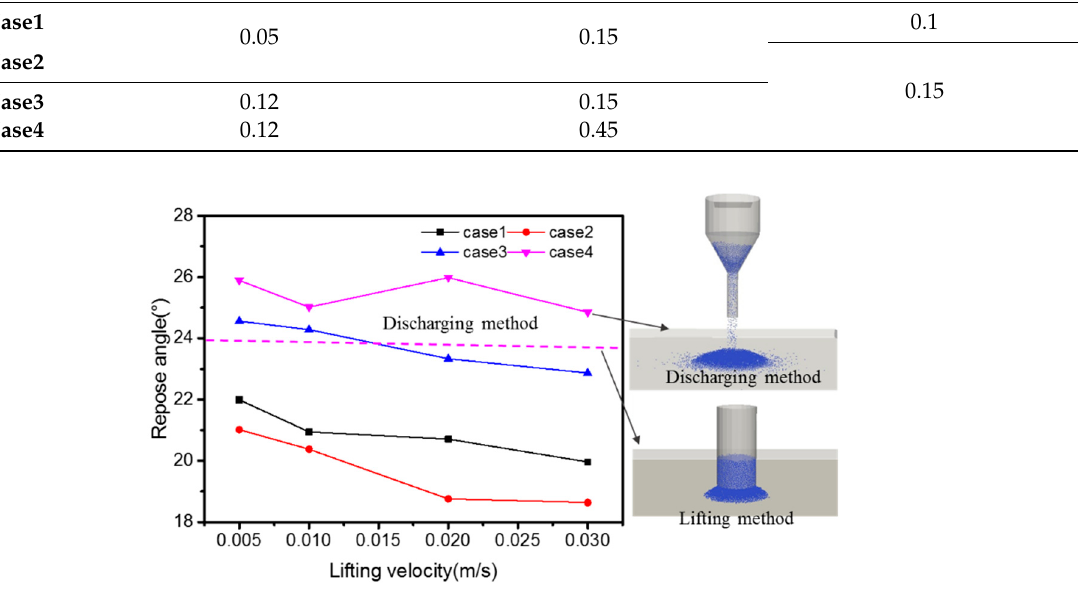
Figure 8. Profile of heap in simulation and experiment.